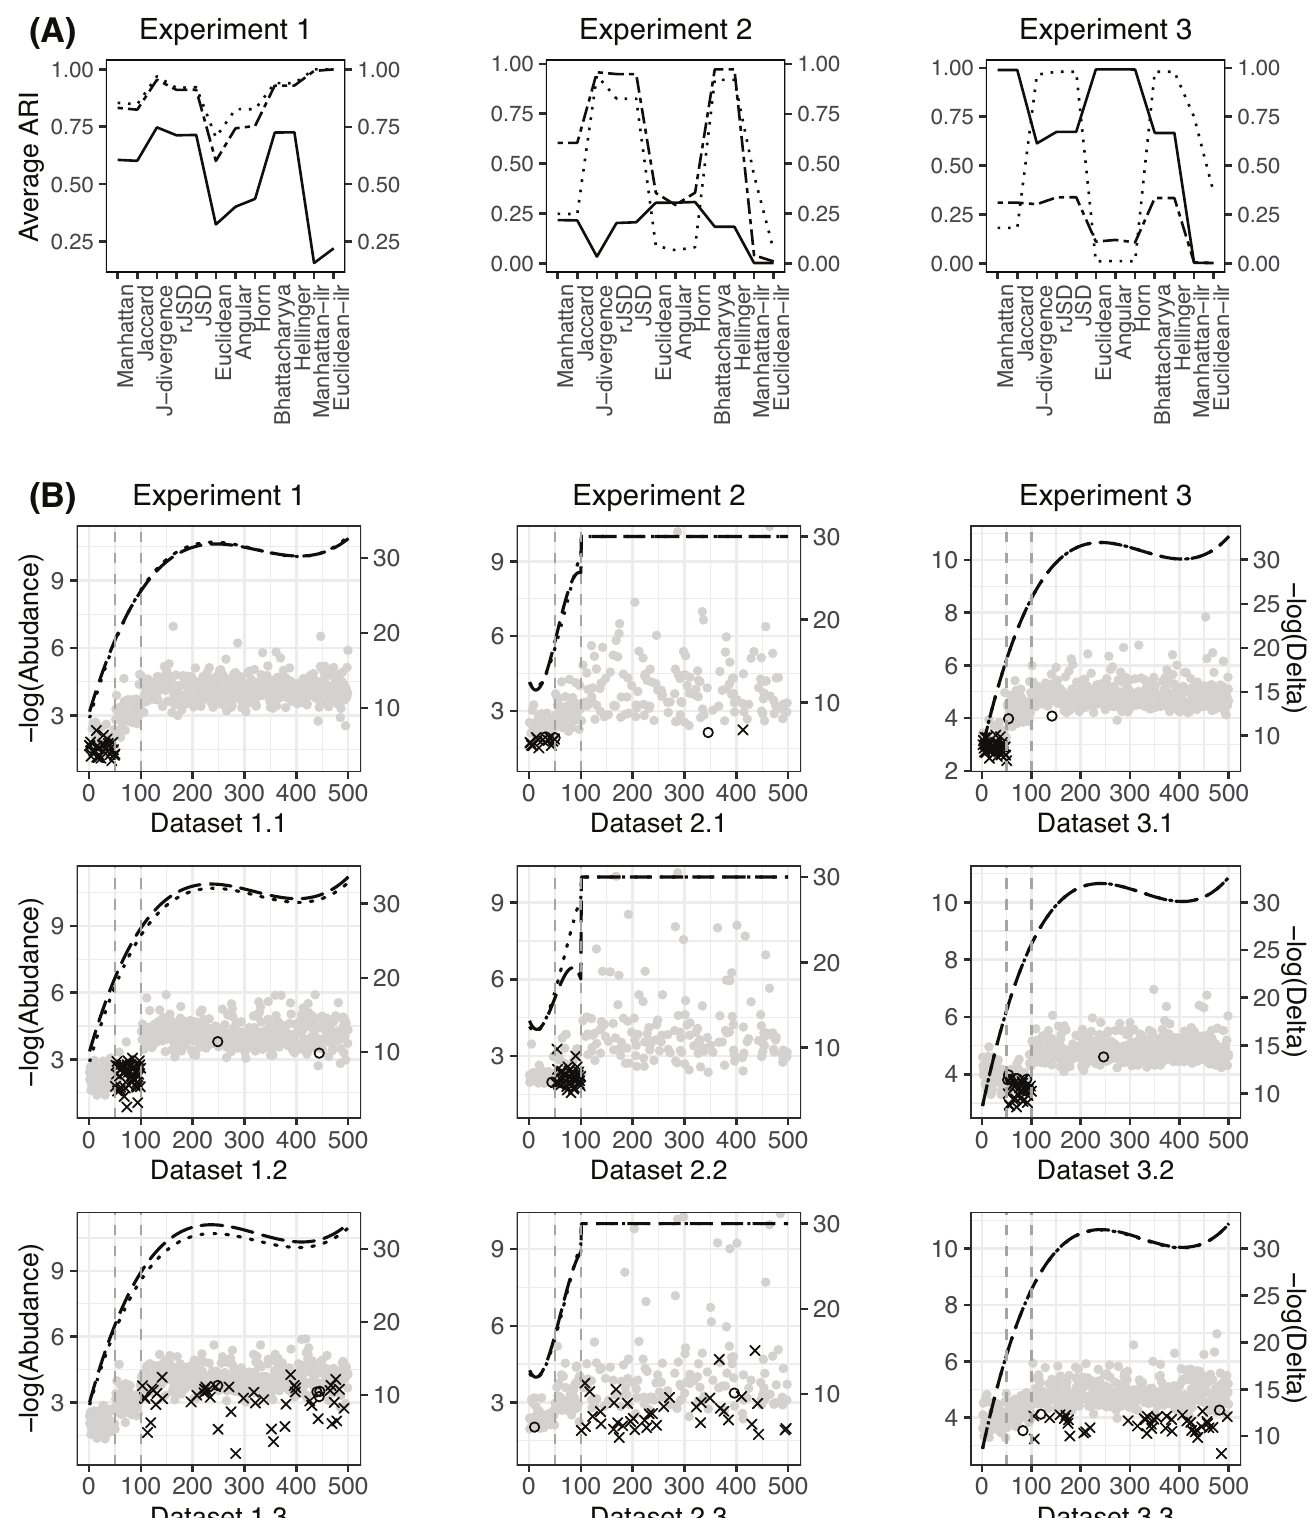
Fig 1. (A) : The average ARIs obtained in simulation experiments 1-3, where the solid, dashed and dotted lines indicate scenarios x.1-x.3, respectively. (B) : The dashed and dotted lines represent the cubic smoothing spline of -log(Abundance) , where Abundance indicates the average abundance of two clusters along all the